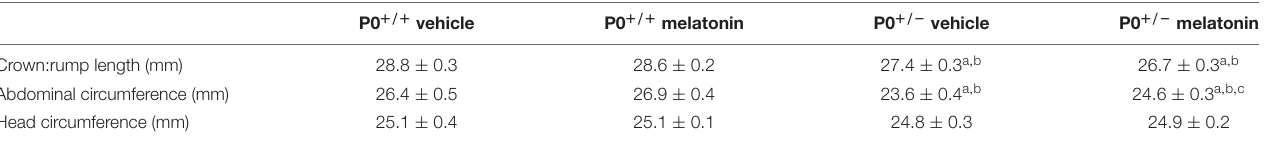
Number of litters as follows; P0 + / + vehicle N = 10, P0 + / + melatonin N = 11, P0 + / − vehicle N = 10, P0 + / − melatonin N = 11. a P < 0.001 compared with P0 + / + vehicle, b P < 0.001 compared with P0 + / + melatonin, c P < 0.05 compared with P0 + / − vehicle, generalized linear mixed models with sequential Sidak post-test.